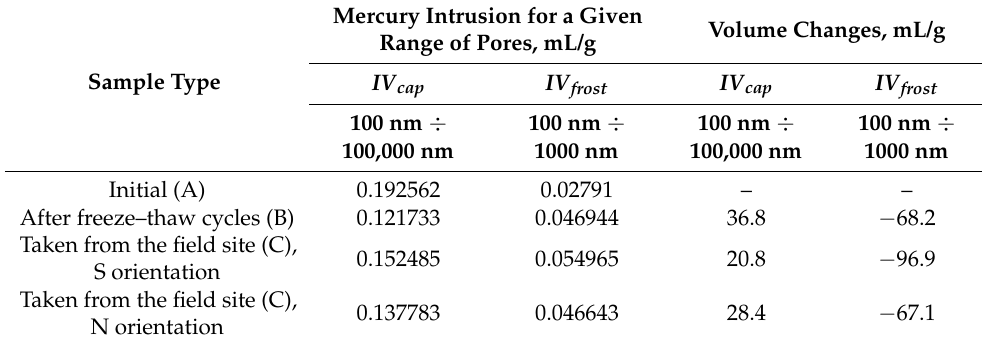
Table 3. Mercury intrusion for defined pore ranges related to capillary transport and frost